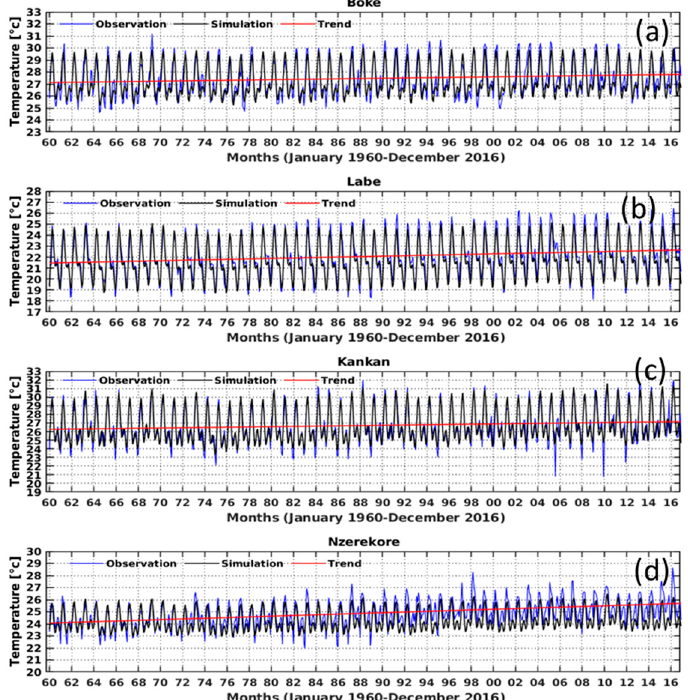
Figure 8. Temporal evolution of monthly surface temperature values (blue line) as observed over Guinea, superimposed by the simulated Trend-Run model (black line), while the straight red lines illustrate the obtained temperature trend at each weather station: ( a ) Boke, ( b ) Labe, ( c ) Kankan and ( d ) N’zerekore for the period from January 1960 to December 2016.